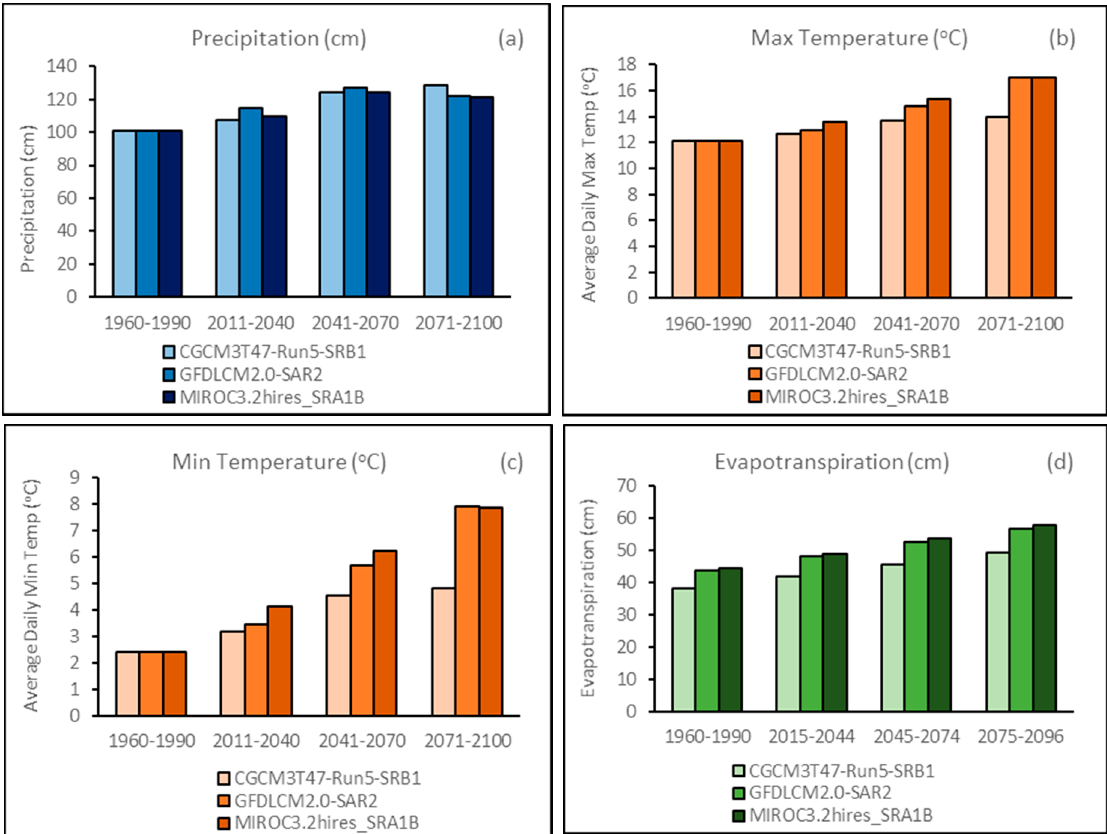
Figure 4. Comparing future climate scenarios (( a ) precipitation; ( b ) maximum average daily temperature; ( c ) minimum average daily temperature; ( d ) evapotranspiration) of the three different climate models applied in this study. Please note that for comparison, measured average annual precipitation, average daily maximum and minimum temperatures for 1960–1990 were 100 cm, 12°C and 2.3°C, respectively.